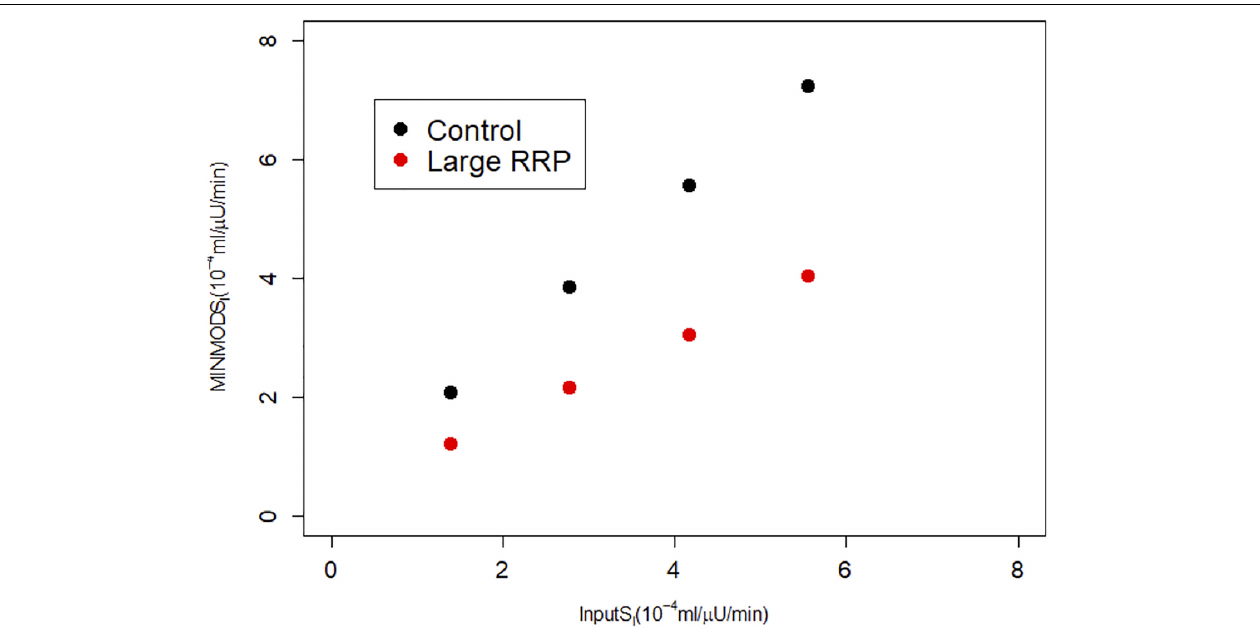
FIGURE 3 | MINMOD estimate of S I vs. the assumed S I , which is systematically underestimated. Parameters are in Table 1 ; cases are numbered 1–4 from left to right (increasing S I ) for each of Control and Large